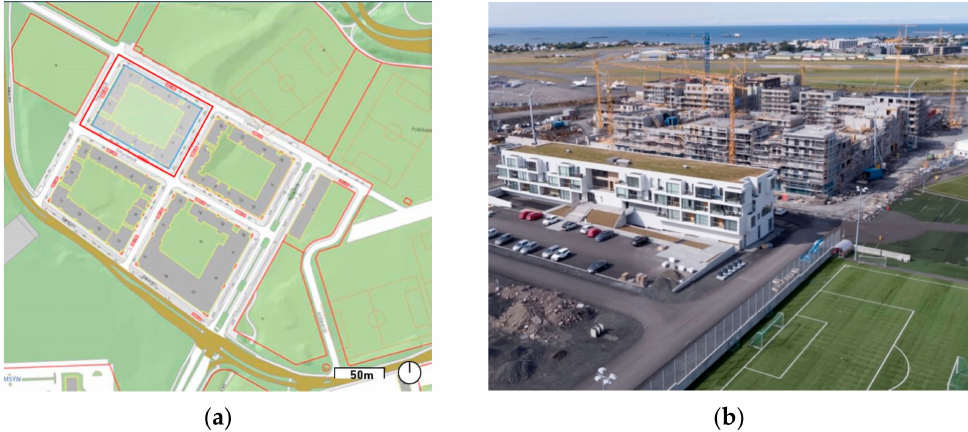
Figure 16. Overview of case study 4: ( a ) cadastral map with location of the lot [49]; ( b ) aerial view of the building complex under construction